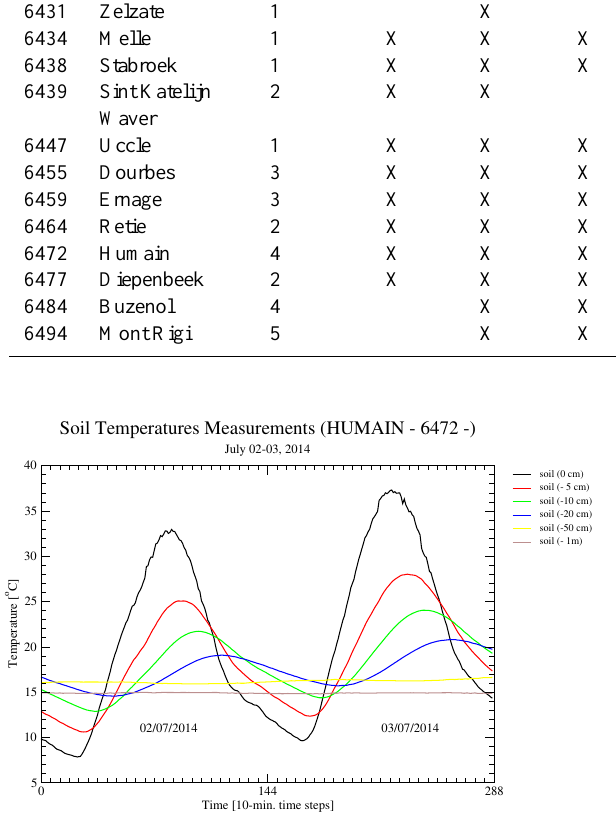
Figure 1. 10-min soil temperature at various depths vs time of the day for 2–3 July 2014, at the Humain station (RMI’s AWS 6472, see Table